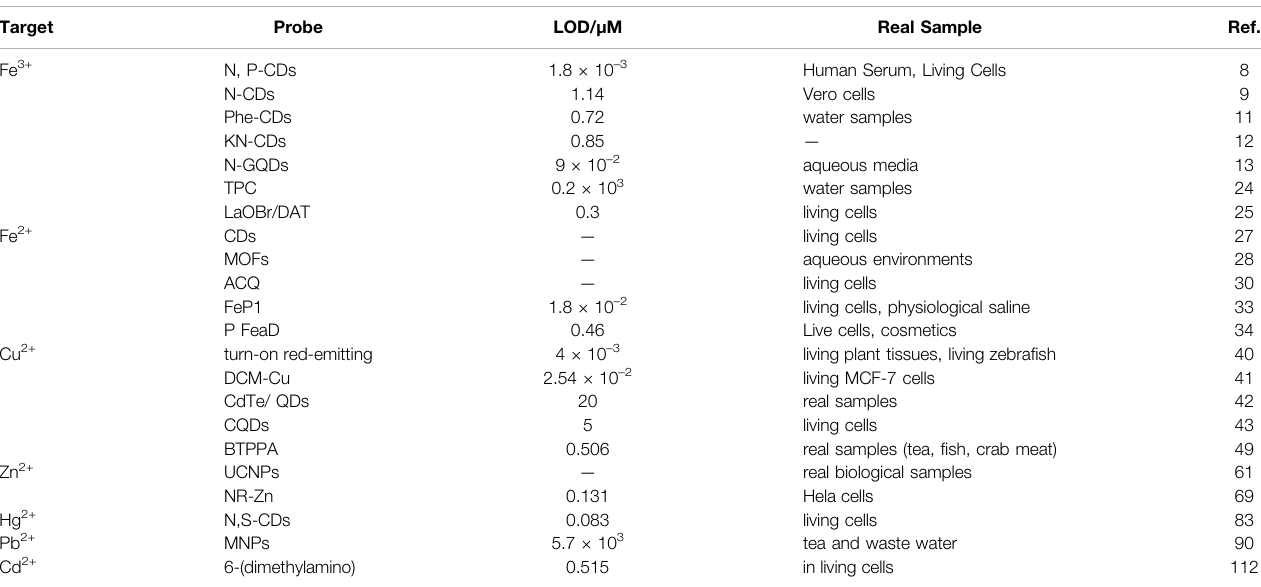
TABLE 1 | List of methods of fl uorescent probe detection of metal ions. Target Probe LOD/ μ M Real Sample